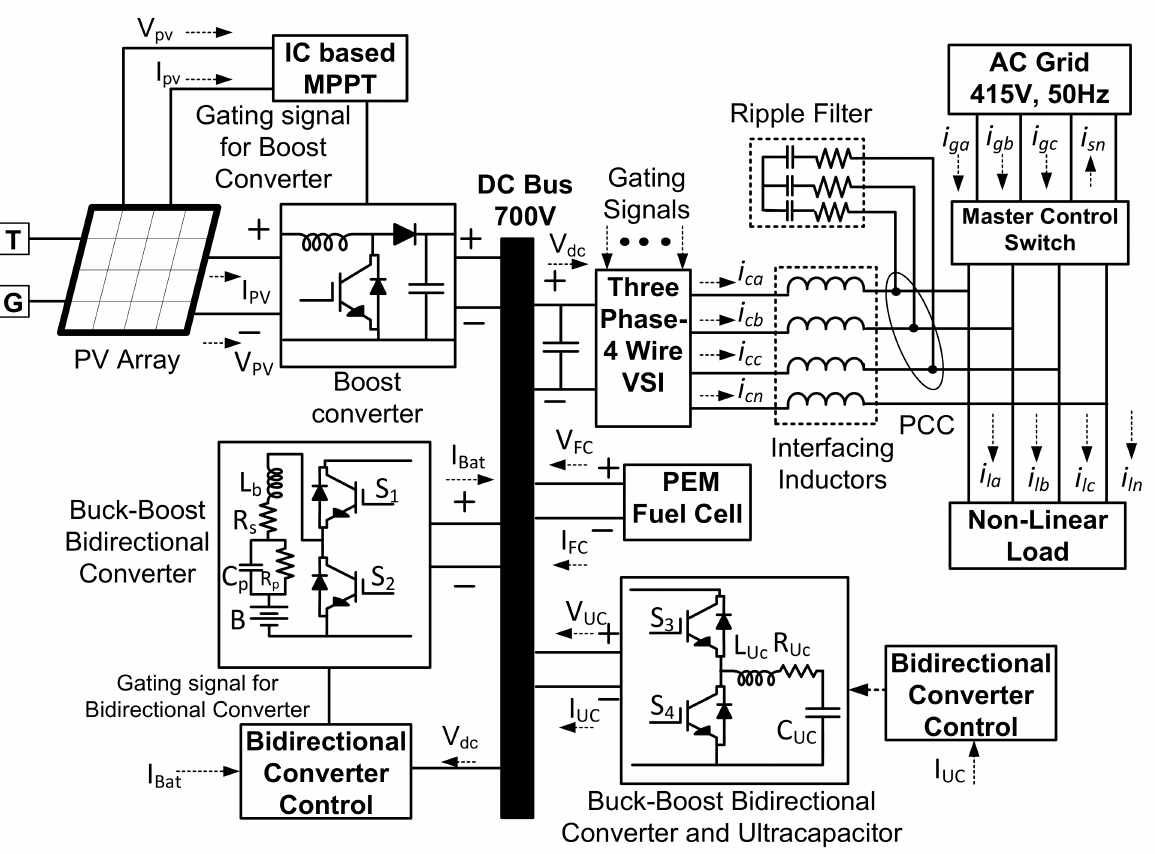
Figure 1. Block diagram of the proposed